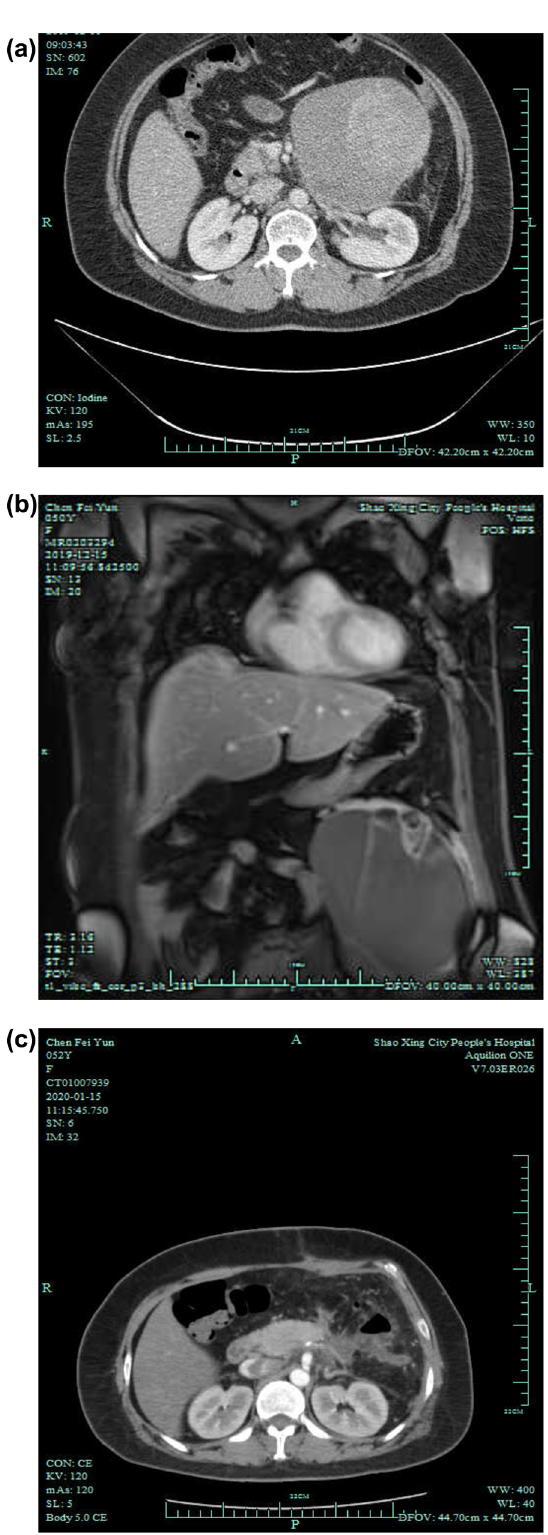
Figure 1: Imaging examinations. ( a ) Preoperative CT. ( b ) Preoperative MRI. The left abdominal cavity shows a massive mass ( 15cm × 12cm ) . There were septa and wall nodules, and the enhanced scanning septum and wall nodules were signi fi cantly enhanced. The adjacent peritoneum was slightly thickened, and the adjacent pancreas was pressurized and pushed upward, with an unclear boundary with the lesion. ( c ) Postoperative CT at 3 months after